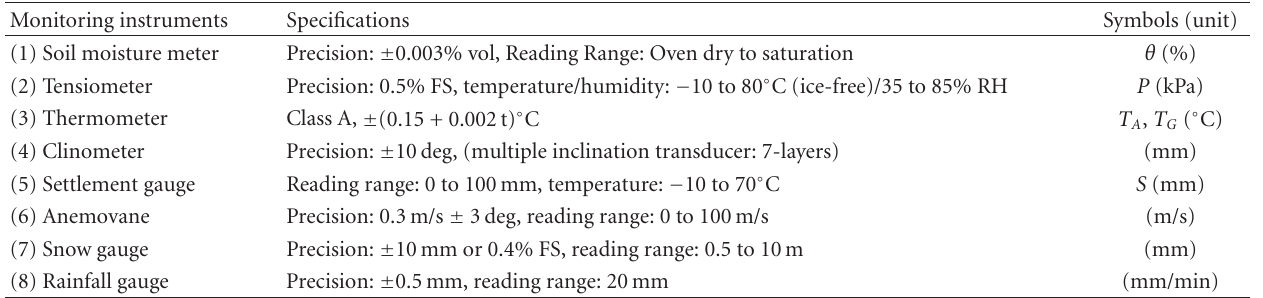
Table 1: Specifications of monitoring instruments.